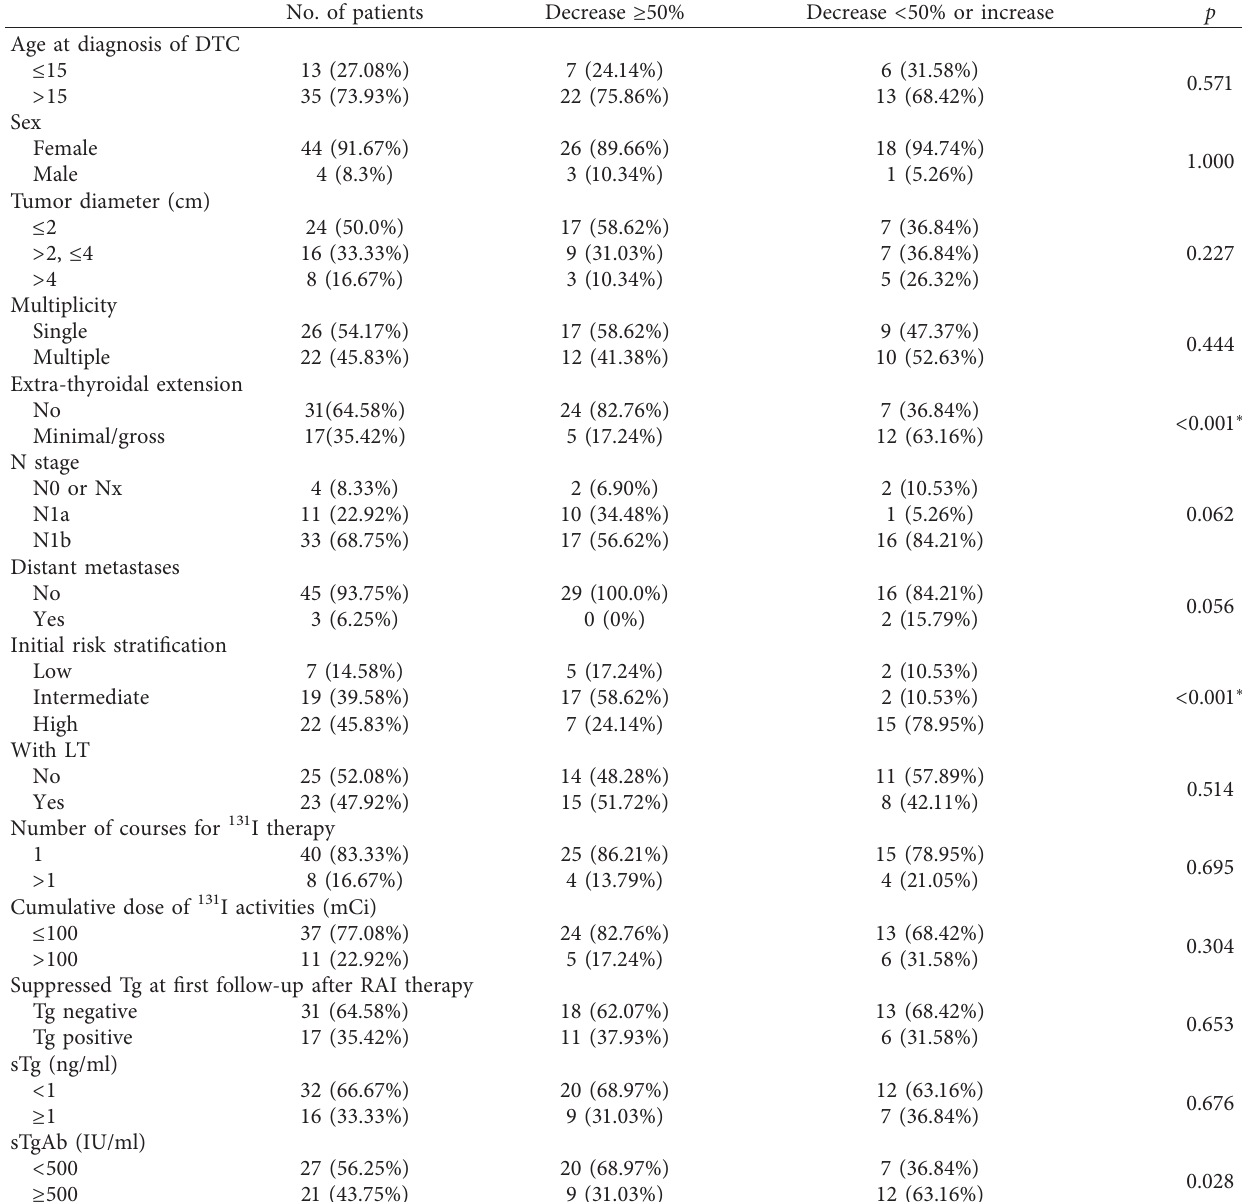
Table 6: Clinicopathologic factors associated with the TgAb